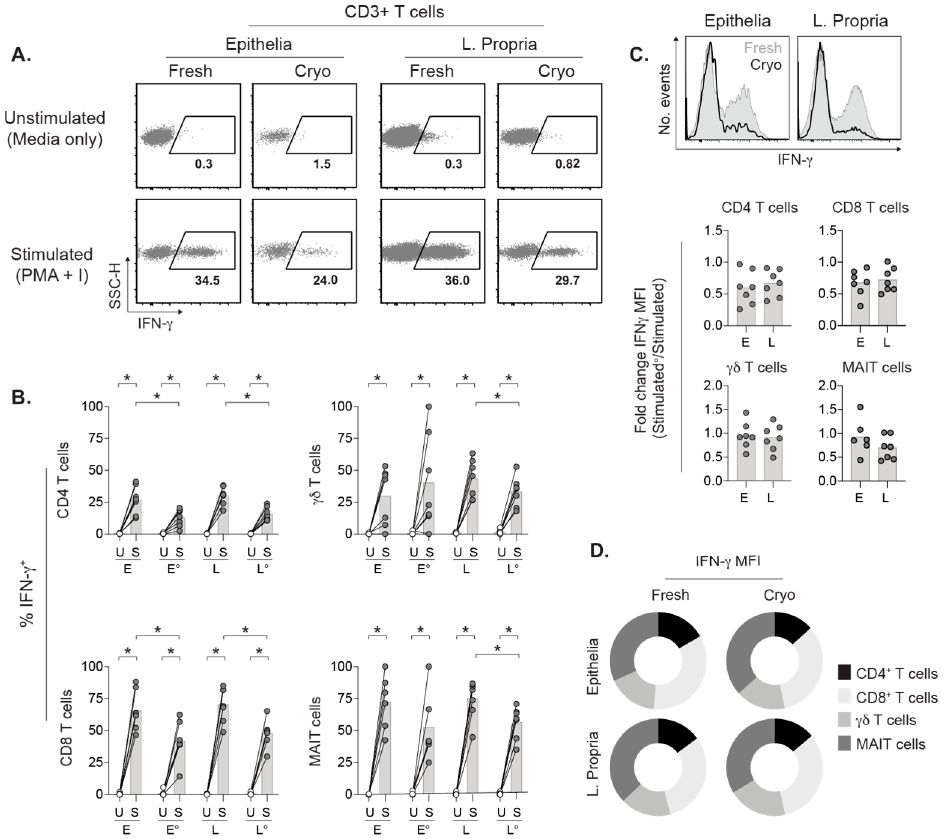
Figure 4. IFN- γ responses are maintained in TILs after cryopreservation. ( A ) IFN- γ expressed by CD3+ TILs stimulated with PMA and ionomycin or left unstimulated. Percentages of parent population shown. ( B ) Frequencies of IFN- γ + TIL subsets in unstimulated (U) or stimulated (S) suspensions. ( C ) Histograms of IFN- γ staining on CD3+ TILs in fresh and cryopreserved tumors with IFN- γ staining intensity on x-axis and cell event numbers on y-axis. Fold changes represent mean fluorescence intensity (MFI) of IFN- γ staining for the indicated TIL subsets in frozen tumor portion, divided by MFI of the same TIL subset in the fresh portion. ( D ) Proportional distribution of IFN- γ + TIL subsets. E and L denotes epithelia and lamina propria, respectively, and ◦ indicates cryopreserved samples. Bars show the mean. (* p < 0.05, Wilcoxon signed-rank